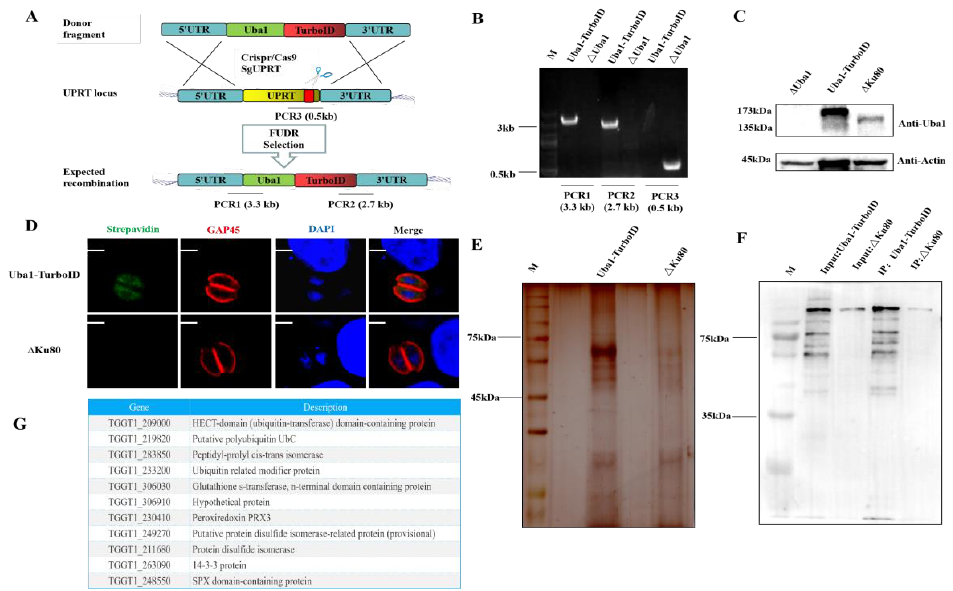
Figure 7. TurboID labeling of TgUba1-proximal proteins. ( A ) Tachyzoites expressing TgUba1-TurboID generated by CRISPR/Cas9-mediated genome editing. The red bar indicated the sgRNA target region. ( B , C ) Single-clone PCR and western-blot identification of TgUba1-TurboID. ( D ) Confocal microscopy image of tachyzoites expressing TgUba1-TurboID cultured in the presence of 500 μm biotin for 24 h. Scale bar, 2.5 μm. ( E ) Silver staining test analysis of lysates obtained from tachyzoites expressing the TgUba1-TurboID fusion protein. ( F ) Analysis of cell lysates by western blotting. ( G ) Analysis of mass spectrometry data.